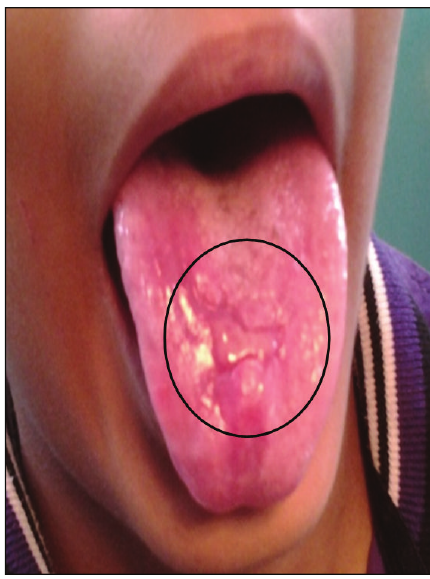
Figure 6: Mid treatment photograph showing resolution size of the lesion.